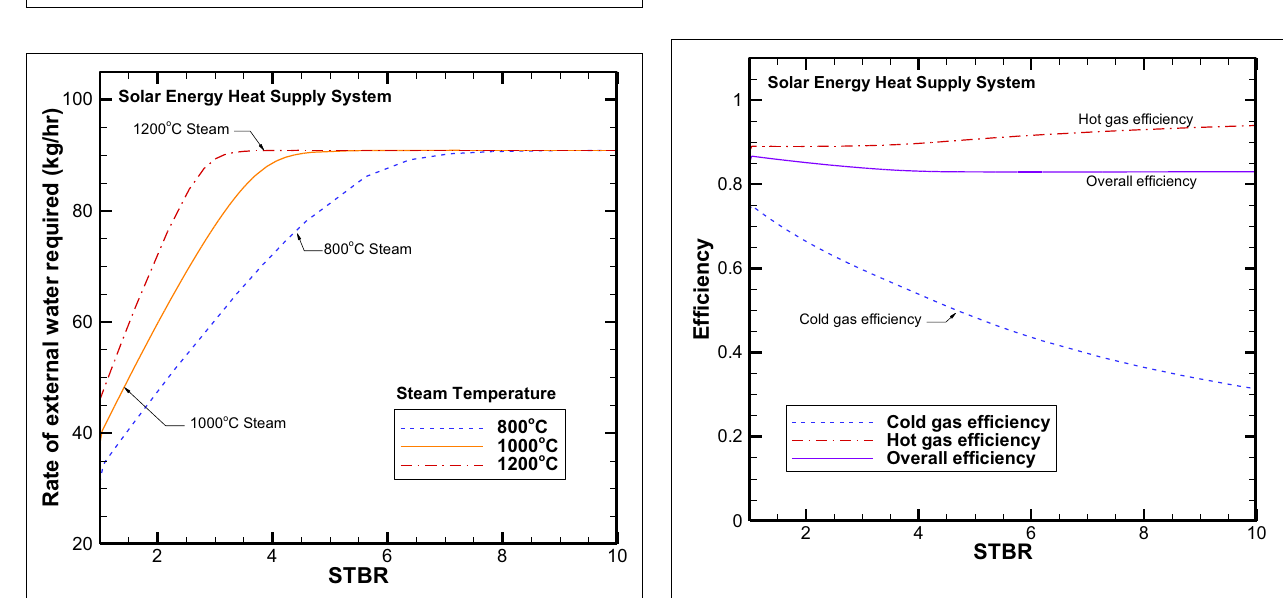
FIGURE 12 | Net hydrogen generation rate for concept system II as a function of STBR .